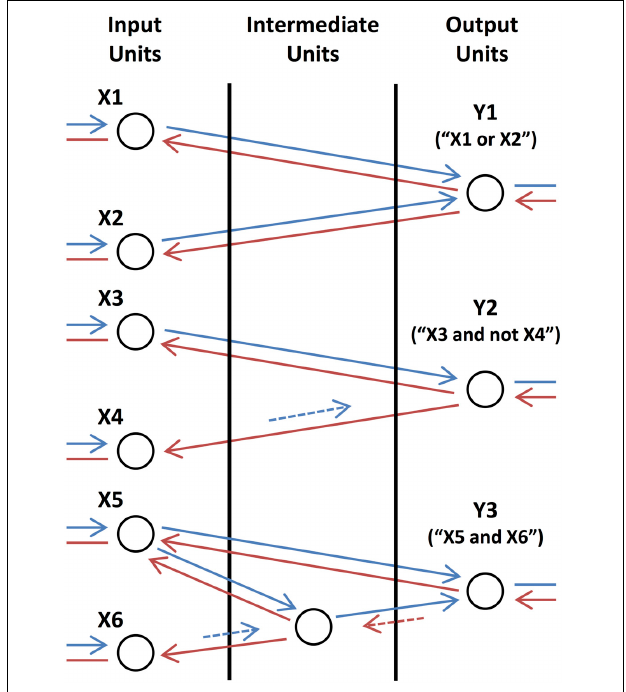
FIGURE 3 | Basic Logic Motifs. From top to bottom, motifs in which the output units compute the operations “X1 or X2,” “X3 and not X4,” and “X5 and X6,” respectively. Arrows correspond to feedforward (blue) and feedback (red) connections with short (dashed and shorter length) and long (solid and longer length) time lags. Arrows are also shown connecting the input units to lower-level units (not shown) and connecting the output units to higher-level units (not shown) as these motifs function as circuits in a larger